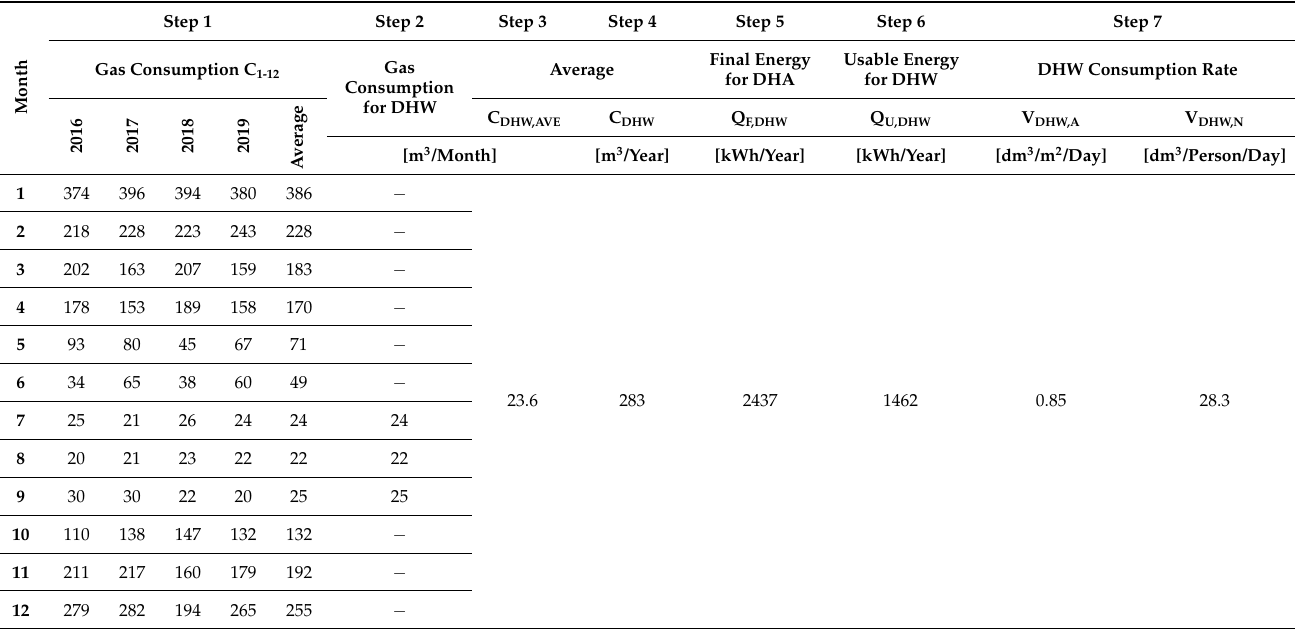
Table 5. Determination of DHW consumption indicators for building B3 (according to the diagram in Figure 1).